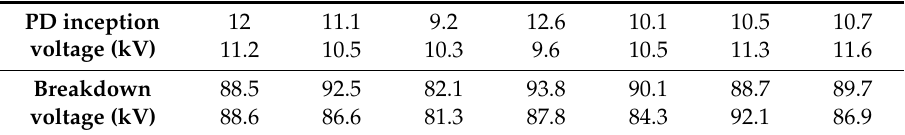
Table 1. The data of the explorative experiment.